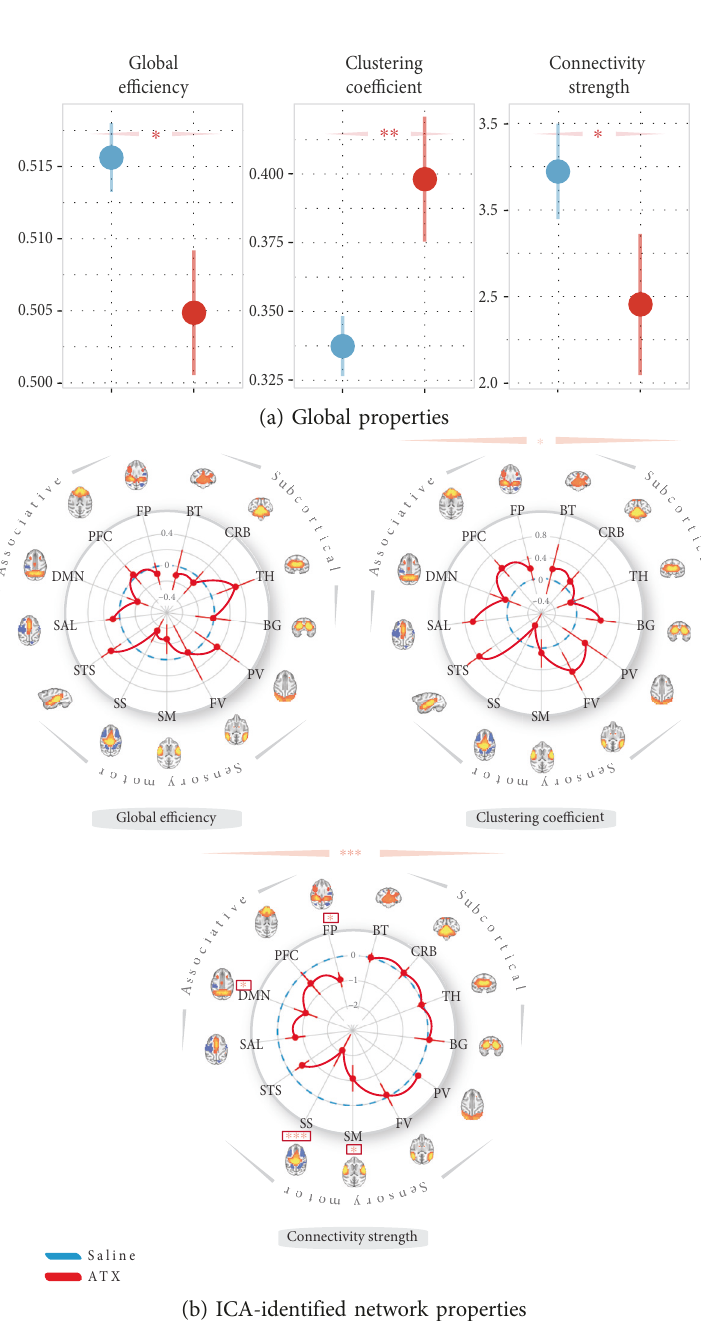
Figure 2: ATX e ff ect on network architecture — (a) global graph properties. Global e ffi ciency, clustering coe ffi cient, and connectivity strength, under saline (blue) and ATX (red) pharmacological conditions. (b) ICA-identi fi ed network properties. The three spider plots represent the global e ffi ciency, the clustering coe ffi cient, and the connectivity strength computed for each ICA-identi fi ed resting-state networks (see Guedj et al. [49]). Importantly, these scores were expressed as a di ff erence between the ATX condition and the saline control condition. Blue lines represent no di ff erence between the two pharmacological conditions (di ff erence equals to 0). Red stars indicate statistical di ff erences between saline and ATX conditions: stars above the spider plots indicate a main e ff ect of the pharmacological condition while stars above the networks indicated an interaction between the pharmacological condition and the ICA-identi fi ed network type ( ∗∗∗ = p value < 0.0001; ∗∗ = p value < 0.001; ∗ = p value < 0.05). Throughout this fi gure, the results are plotted as mean ± SEM. ATX=atomoxetine, BG=basal ganglia, BT =brainstem, CRB =cerebellum, DMN =default-mode network, FP=frontoparietal, FV =foveal visual, ICA=independent component analysis, PFC=prefrontal cortex, PV=peripheral visual, SAL=salience, SM=somatomotor, SS=somatosensory, STS=superior temporal sulcus, and TH